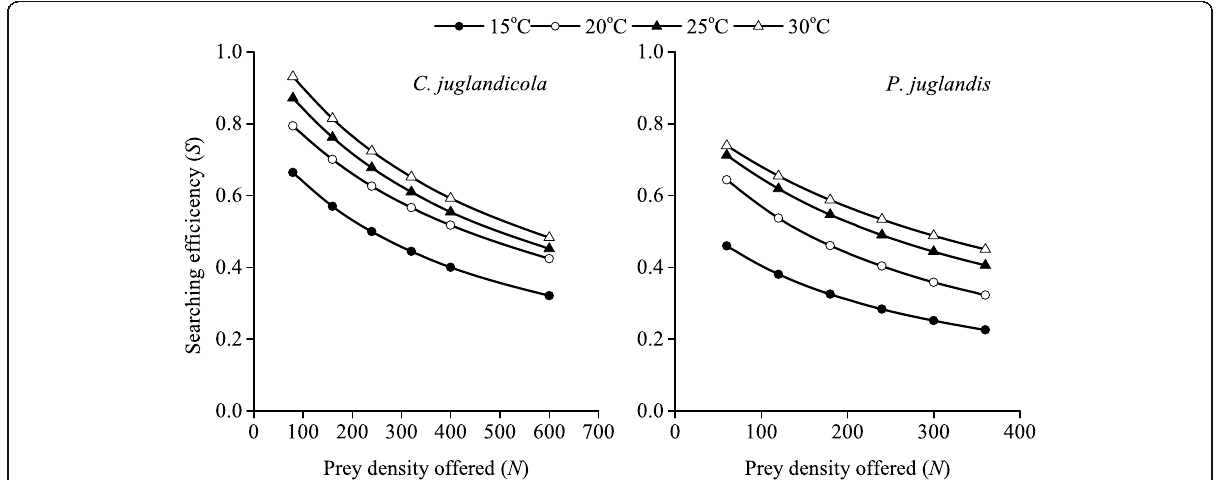
Fig. 2 Searching efficiency by H. axyridis of two walnut aphid species C. juglandicola and P. juglandis under four different temperature